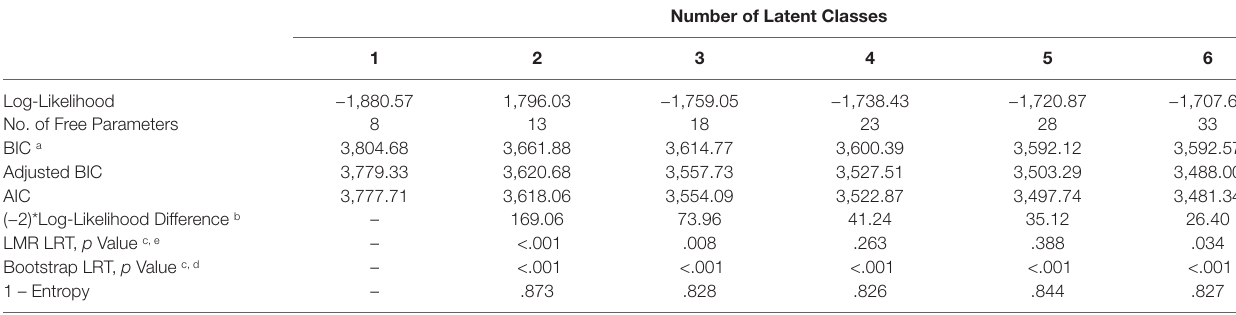
TABLE 1 | Model Fit of the Latent Profile Analyses With Up to Six Latent Classes (N = 215).